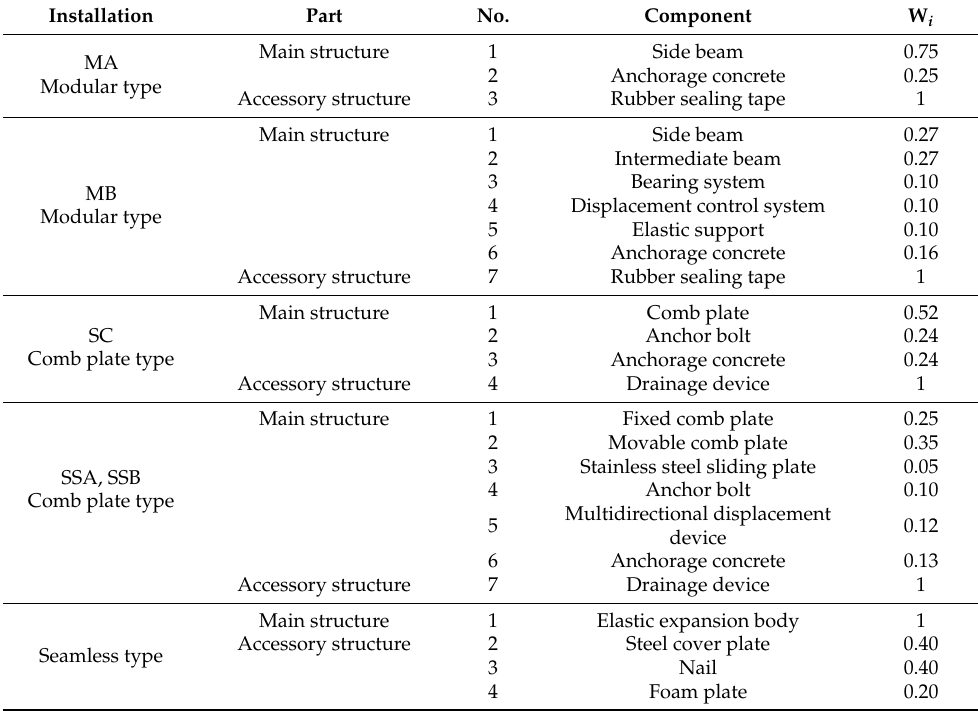
Table 9. Calculation weight of the